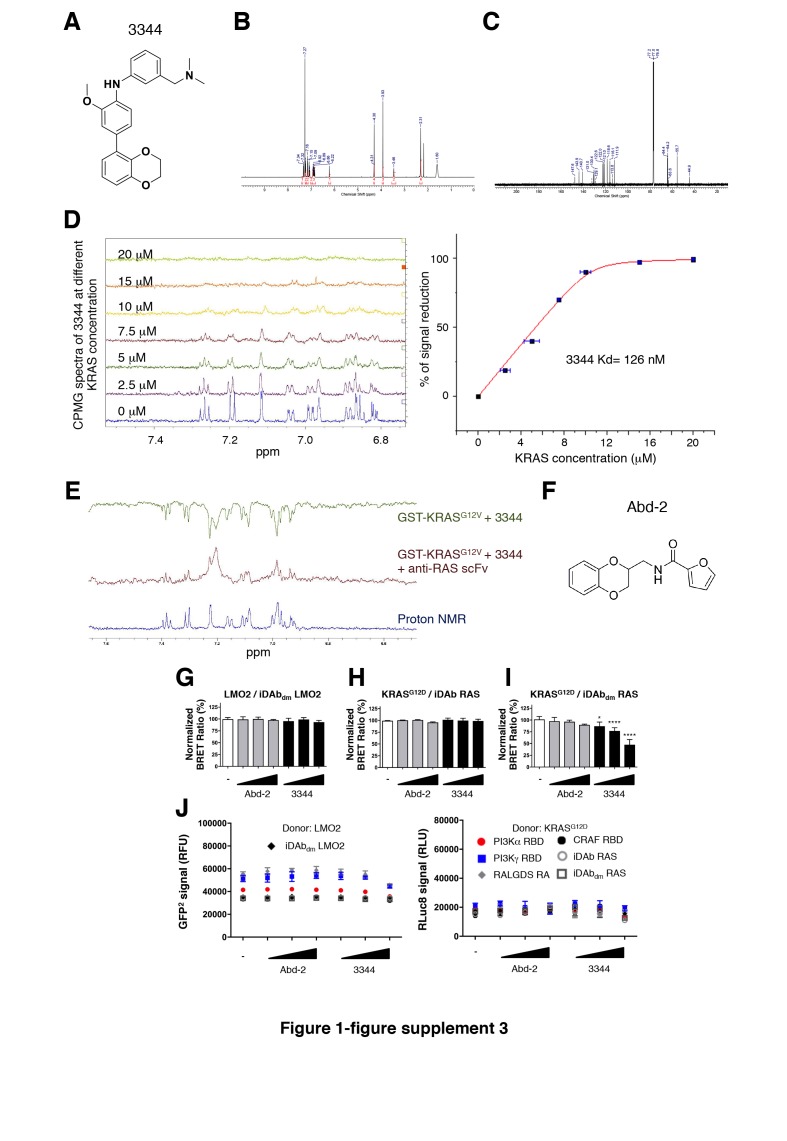
3344 inhibits RAS-RBD interactions.(A) Chemical structure of 3344. (B) 1H NMR and (C) 13C NMR spectra of 3344 were recorded on a Bruker Avance spectrometer (600 MHz) at room temperature in a solution of the deuterated solvent (CDCl3). The field was locked by external referencing to the relevant deuteron resonance. Chemical shifts are reported in parts per million (ppm). (D) NMR Carr-Purcell-Meiboom-Gill (CPMG) evaluation of 3344 Kd. Dose-dependent CPMG spectra of 3344 (at a fixed concentration of 55 μM) were recorded on a Bruker Avance spectrometer (700 MHz) at room temperature against an array of concentration of GST-KRASG12V(0 to 20 μM, left hand panel). The amount of protein was increased from 0 μM until the signals of the compound completely disappear in the proton NMR (here 20 μM). The integrations of the proton acquired were all compared to the compound alone (0 μM of protein) in order to obtain a percentage of decrease for each concentration of GST-KRASG12V. Concentration and percentage of decrease were plotted and Kd fitting was run on the generated binding curve using Origin® software (right hand panel, see Materials and methods for details). (E) WaterLOGSY spectra of 3344 interacting with GST-KRASG12V-GppNHp. The proton NMR of 3344 is the lower spectrum (blue), the spectrum of 3344 with KRAS is shown in the top (green) and the inhibitory effect of added anti-RAS scFv on 3344 binding to KRAS is shown in the middle spectrum (red). (F) Chemical structure of Abd-2. (G–I) 3344 decreases KRASG12D-iDAbdm RAS interaction in a dose-dependent manner and not with iDAb RAS or with a negative BRET-biosensor LMO2-iDAbdm LMO2. Statistical analyses were performed using a one-way ANOVA followed by Dunnett’s post-tests (*p<0.05, ****p<0.0001). (J) Total GFP2 and RLuc8 levels from the BRET competition assay shown in G-I and Figure 1E. Each experiment was repeated four times (G–I). Where error bars are presented, they correspond to mean values ± SD of biological repeats.